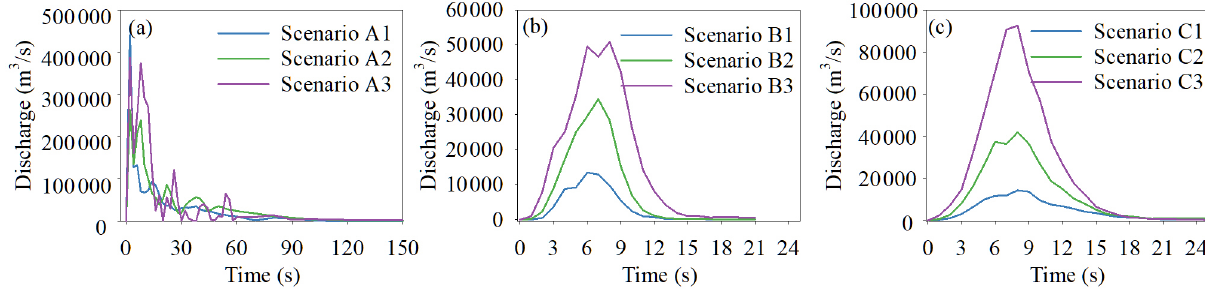
Figure 7. Time series of material entry into the lake for different ice avalanche and landslide